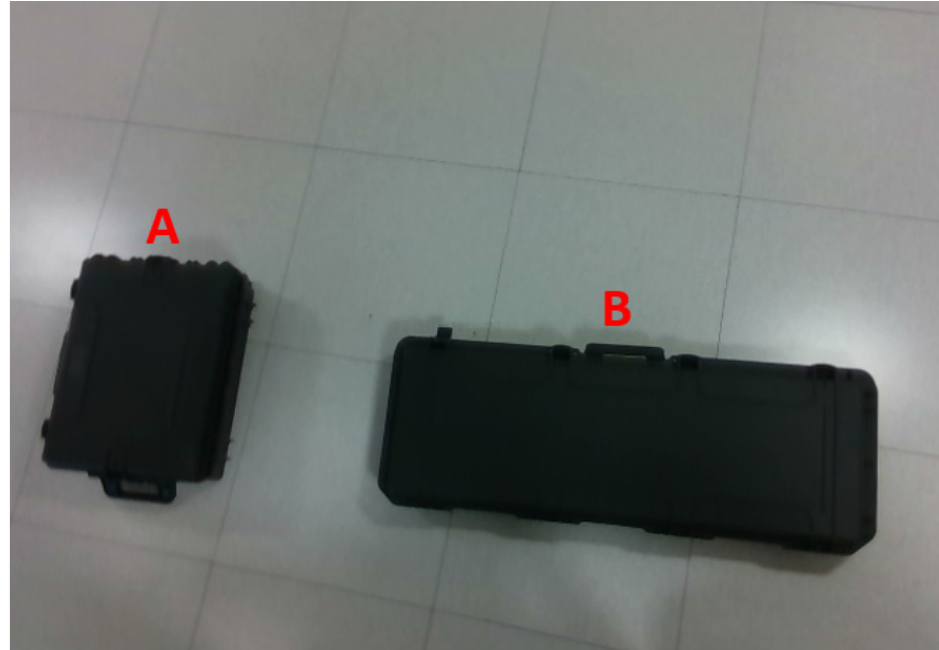
for box B. Using Agisoft Metashape, the registered errors are in the order of 23.1% for box A and 26.5% for the box B.